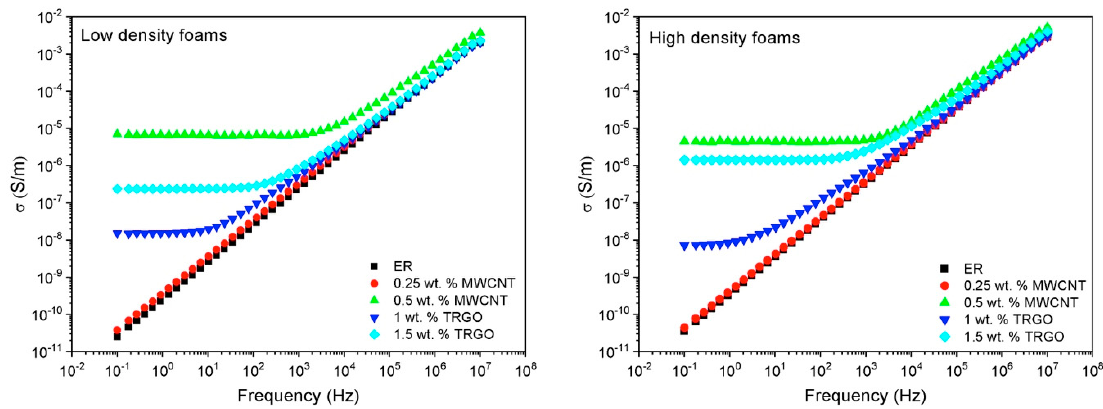
Figure 8. Electrical conductivity of ( left ) LD foams and ( right ) HD foams.